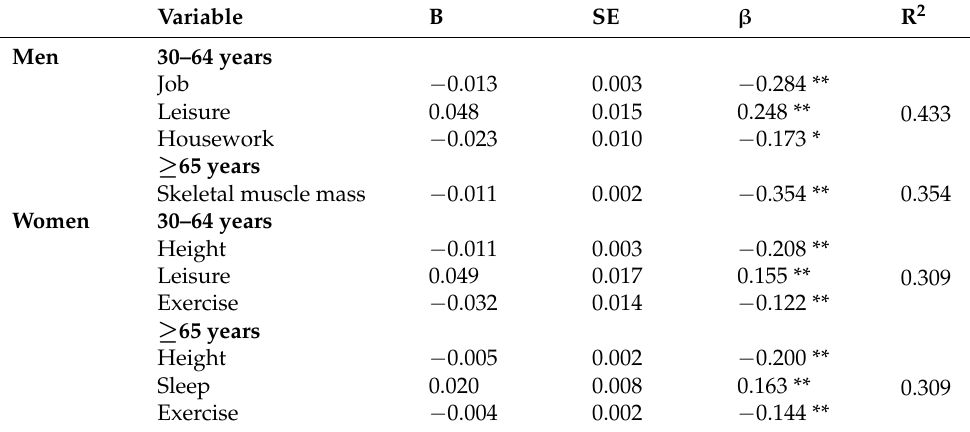
Table 3. Stepwise multiple regression analysis of factors related to TUG time by sex and age group † . Variable B SE